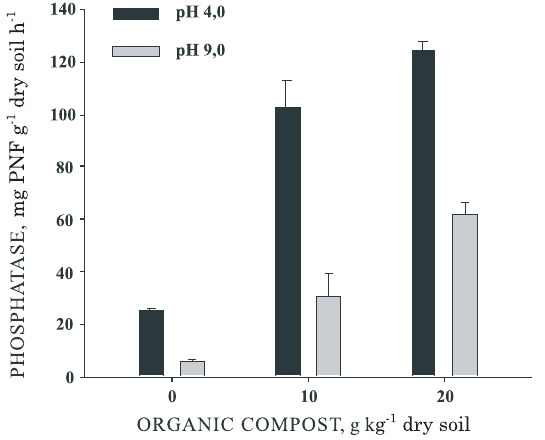
(n=4).Figure 2. Phosphatase enzyme activity (acid: pH 4.0 and alkaline: pH 9.0) due to compost amendment in Acrustox soil. PNF: ρρρρρ -nitrophenol phosphate. Vertical bars indicate average confidence intervals at 5% probability